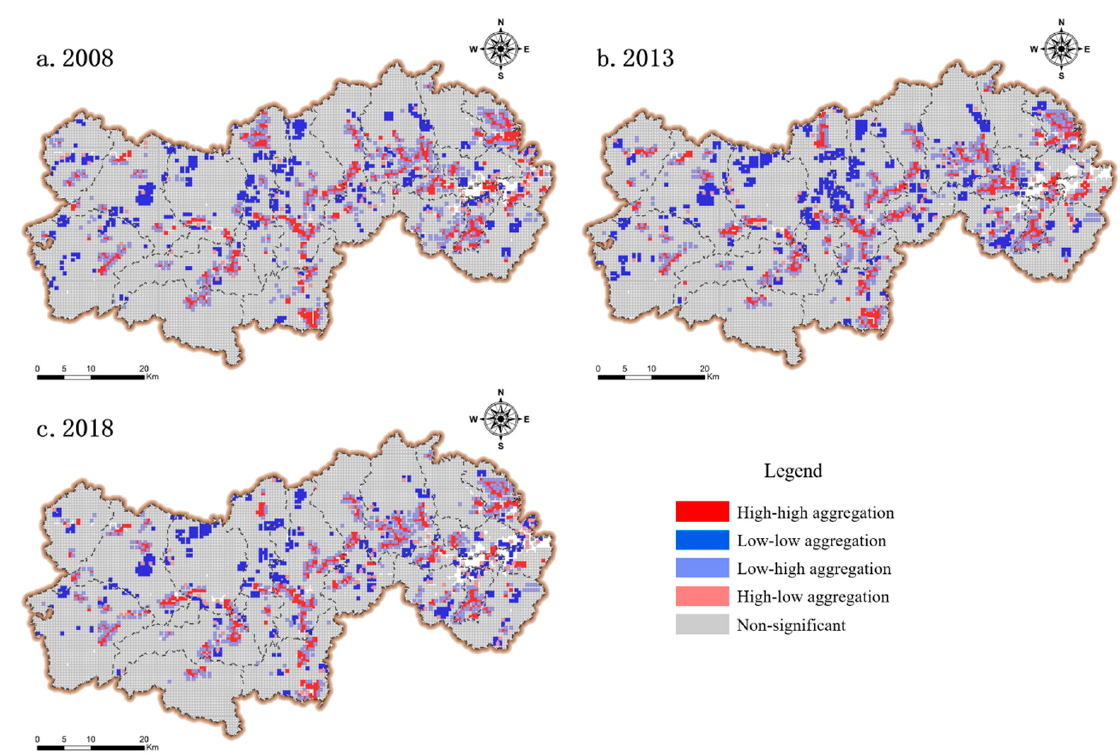
Figure 4. Local spatial autocorrelation of potential land-use conflict in Lin’an District, 2008–2018. ( a ) 2008. ( b ) 2013. ( c ) 2018.